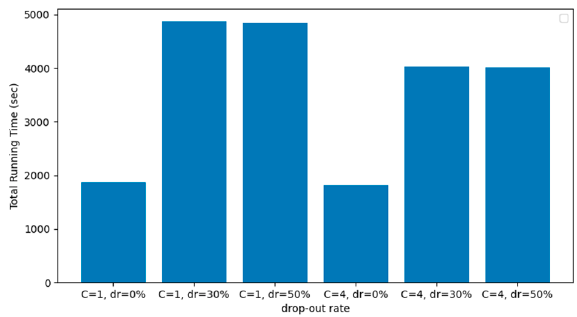
Figure 8. Total running time by dropout rate per cluster.